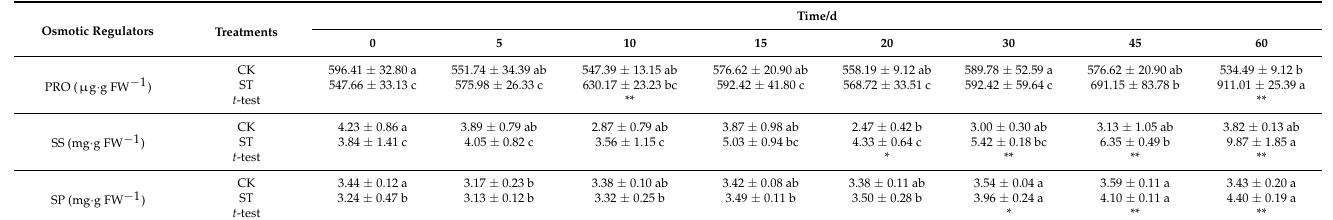
Table 3. Effects of salt stress on osmotic regulators in the seedlings of C. hongkongensis subsp. tonkinensis